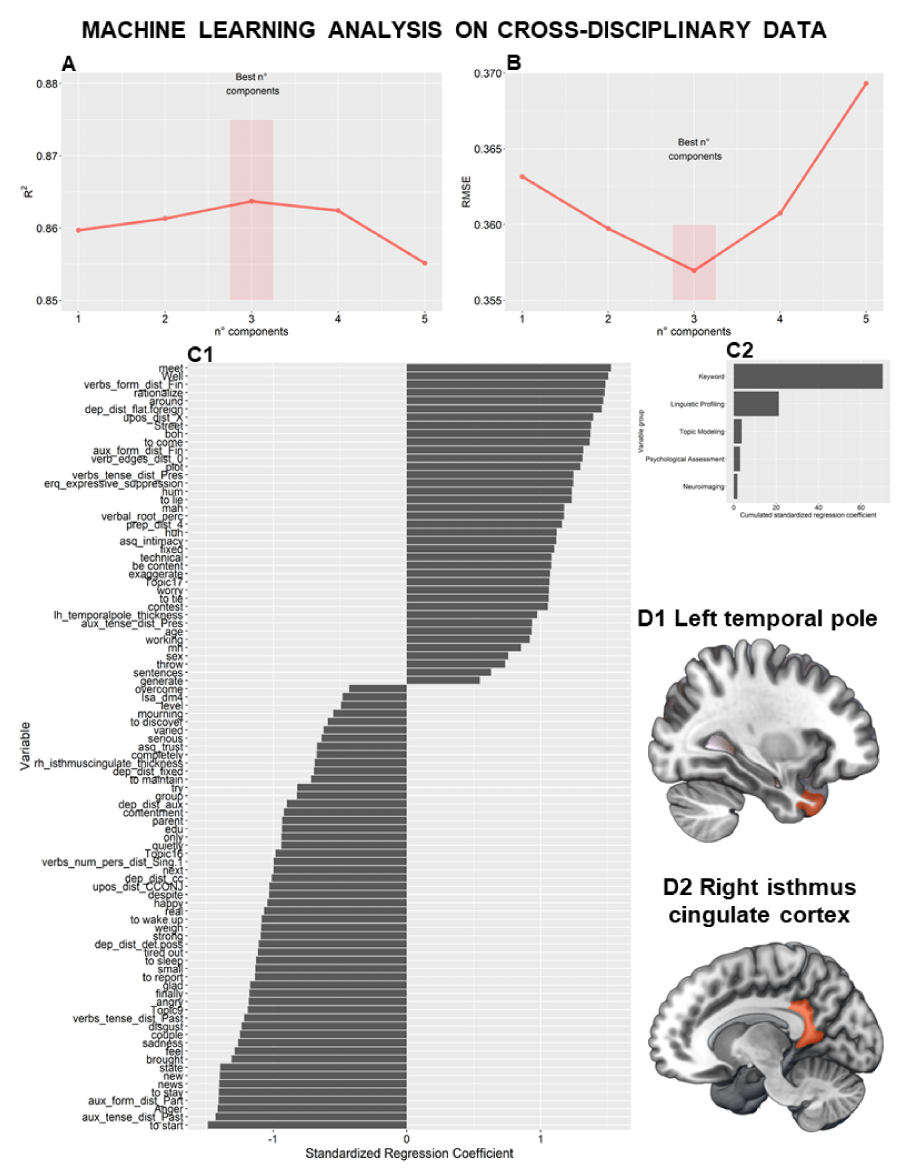
Figure 2. Machine Learning Analysis on Cross-Disciplinary Data. Natural Language Processing (NLP) data were aggregated with demographic, neuroimaging, and psychological data to predict Toronto Structured Interview for Alexithymia (TSIA) scores. Candidate features (n = 92) were extracted using univariate filtering with Spearman correlation method, Principal Components Regression (PCR) model with three components was selected as it had the best performance over evaluation metrics assessed in Leave-One-Out Cross-Validation (LOOCV) (R 2 = 0.86; Root Mean Square Error— RMSE = 0.35) ( A , B ). Variable importance is reported ( C1 , C2 ). Namely, 85 candidate features resulted to belong to NLP, 3 to psychological measures, 2 to neuroimaging data, and 2 to demographic data. The variable importance of neuroimaging data showed that the increased left temporal pole thickness (orange colored area, D1 ) predicted increased TSIA scores, while increased right isthmus cingulate thickness (orange colored area, D2 ) predicted decreased TSIA scores. In ( D1 , D2 ) left is left. Regarding the variable importance of psychological measures, high ERQ Expres- sive Suppression and ASQ Discomfort with Intimacy scores predicted high TSIA scores. Conversely, high ASQ Confidence scores predicted low alexithymia